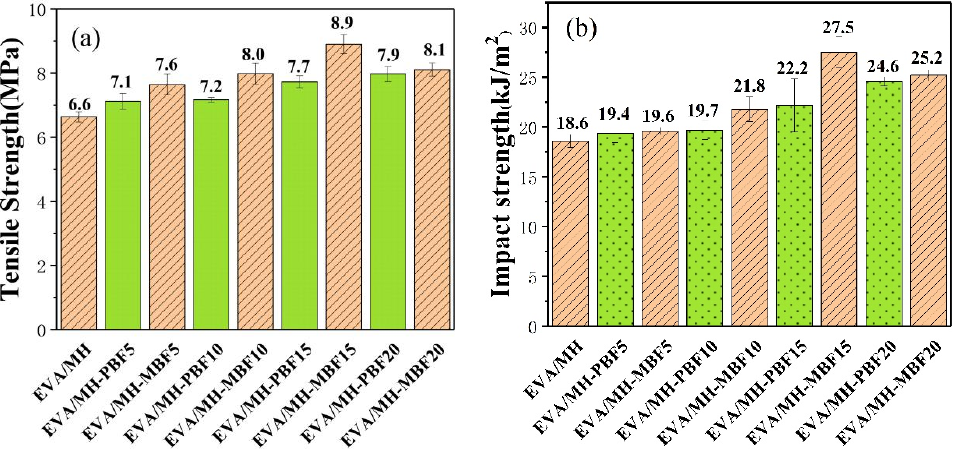
Figure 8. ( a ) Tensile strength, ( b ) non-notched impact strength of EVA/MH-BF composites.